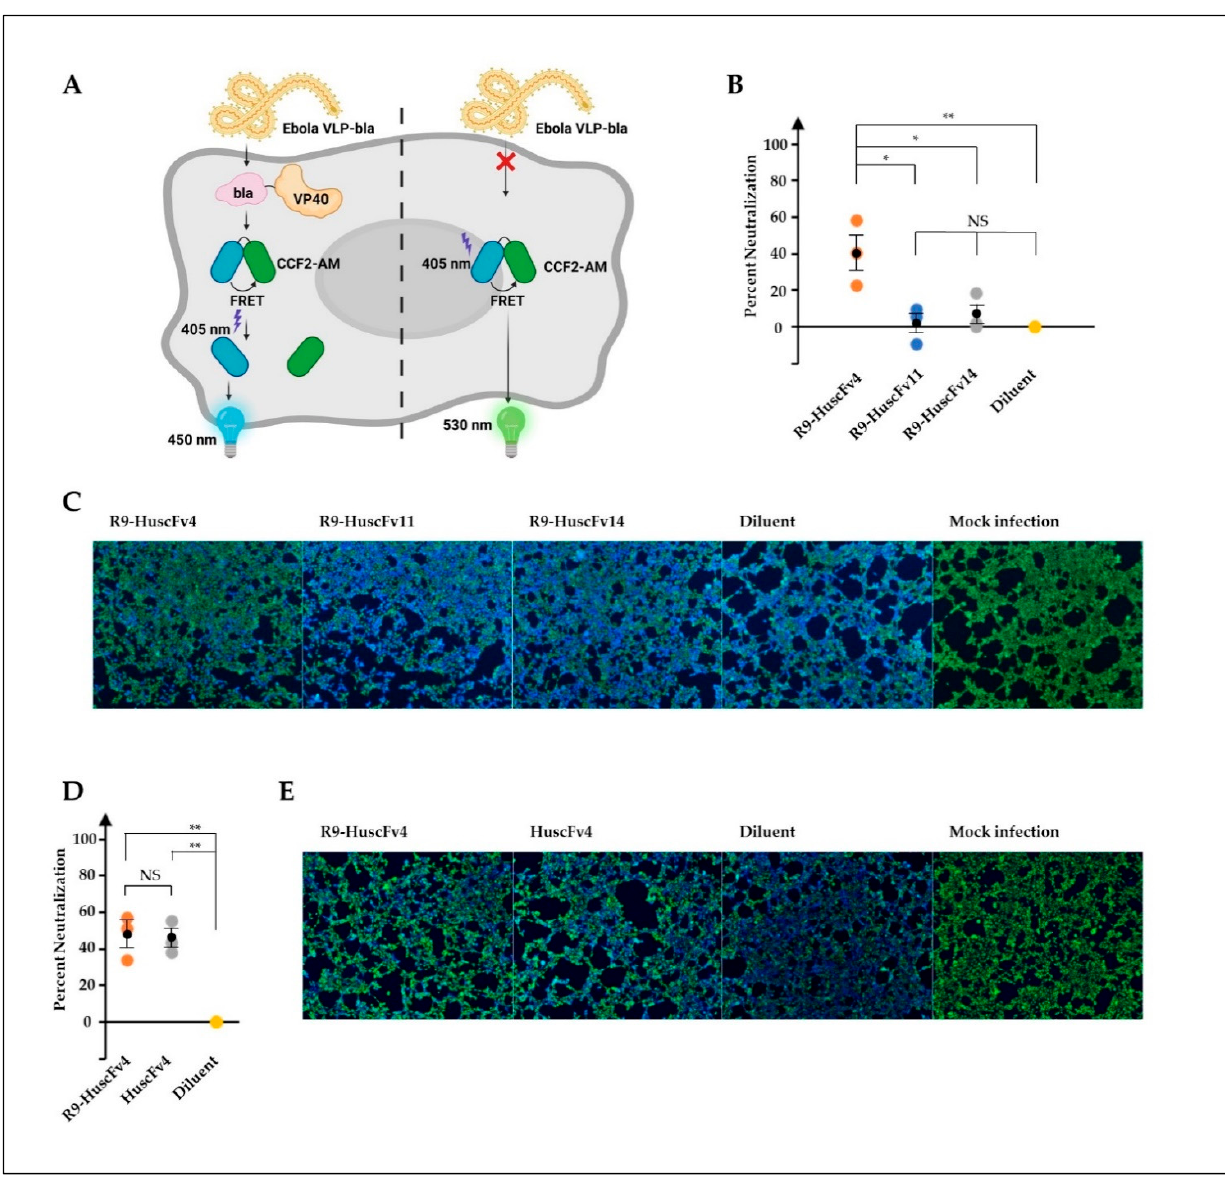
Figure 3. Ability of R9-HuscFvs in inhibition of VLP cellular entry (neutralizing activity). ( A ) Ebola-VLP-based system used in this study. VLP consists of EBOV GP on the surface and VP40 matrix proteins fused with beta-lactamase (bla), which was produced by co-expression of EBOV GP and VP40-bla. Entry of VLP into cells were monitored by measuring bla activity, which cleaved cell-permeable fluorescence resonance energy transfer (FRET) substrate CCF2-AM (green color, emission wavelength at 530 nm), yielding the product (blue color, emission wavelength at 460 nm). ( B – E ) HEK293T cells were spinoculated with VLP, pre-incubated with indicated R9-HuscFvs (30 µg/mL final concentration in wells), the equivalent volume of diluent (diluent), or boiled VLP (mock infection). Percent neutralization (inhibition of cellular entry) was calculated as described in Materials and Methods and is shown in ( B , D ). Representative images of experiments in ( B ) and ( D ) are shown in ( C , E ), respectively. Results in ( B , D ) are shown as mean ± standard error of three independent experiments in triplicates. *, p < 0.05; **, p < 0.01; NS, not significantly different.